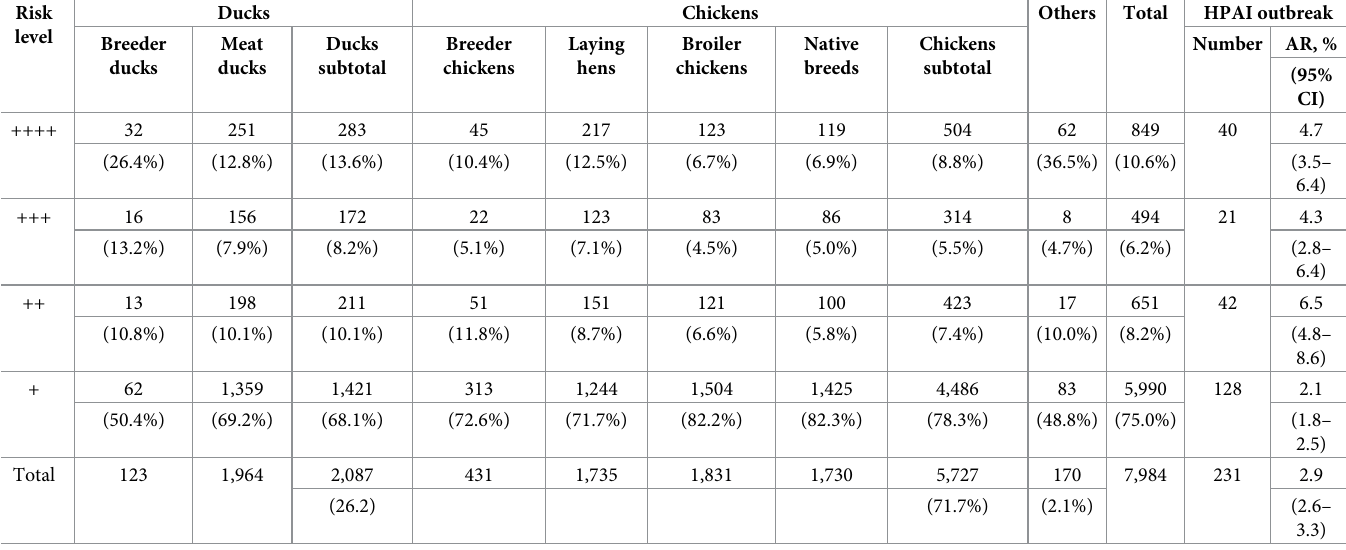
Table 1. Risk level predicted by the risk assessment program and Attack Rate (AR) according to poultry farm